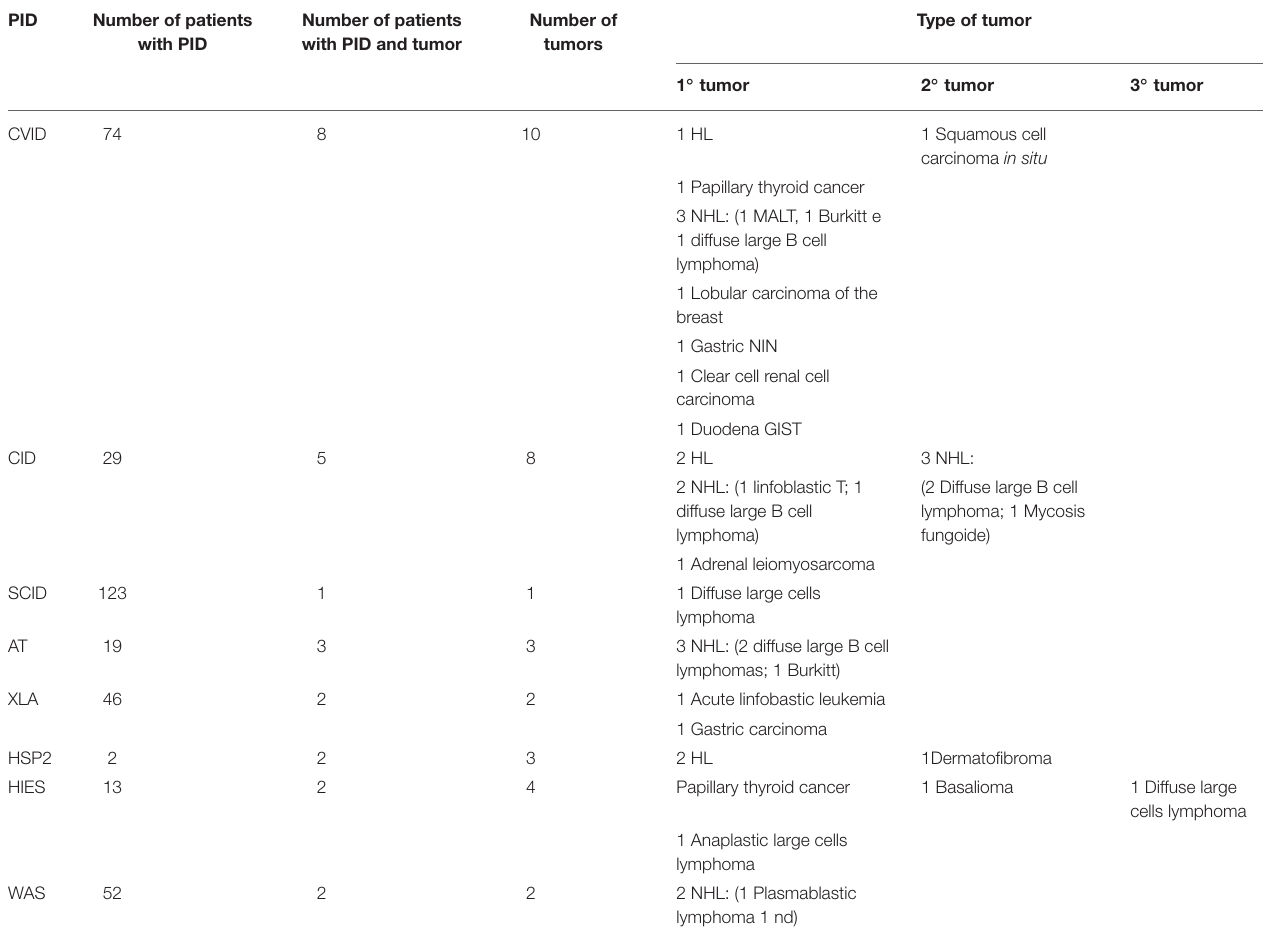
TABLE 3 | Tumor in our patients. PID Number of patients with PID